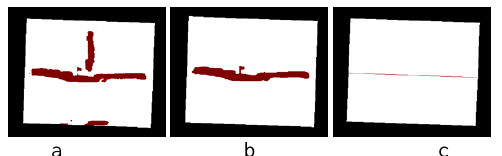
Figure 5. The ridge line detection strategy: a: original ridge lines; b: the ridge line parallel to the main orientation of the polygon; c: the best fitted ridge line